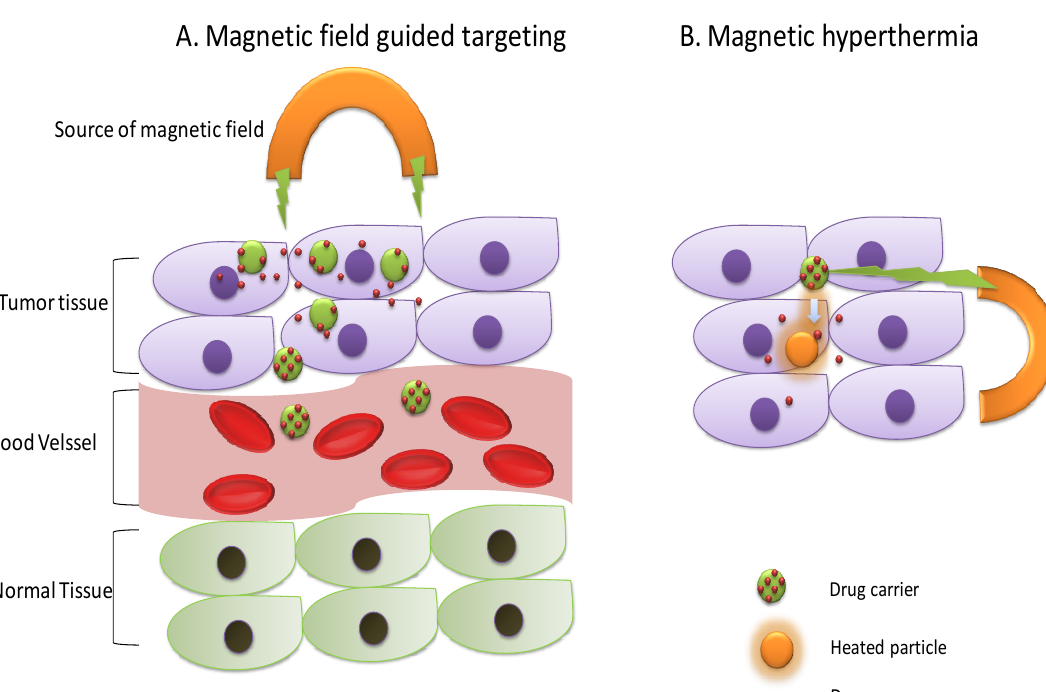
Figure 9. Mechanisms of drug release from magnetic field responsive DDS, which are guided by the magnetic field and magnetic hyperthermia.